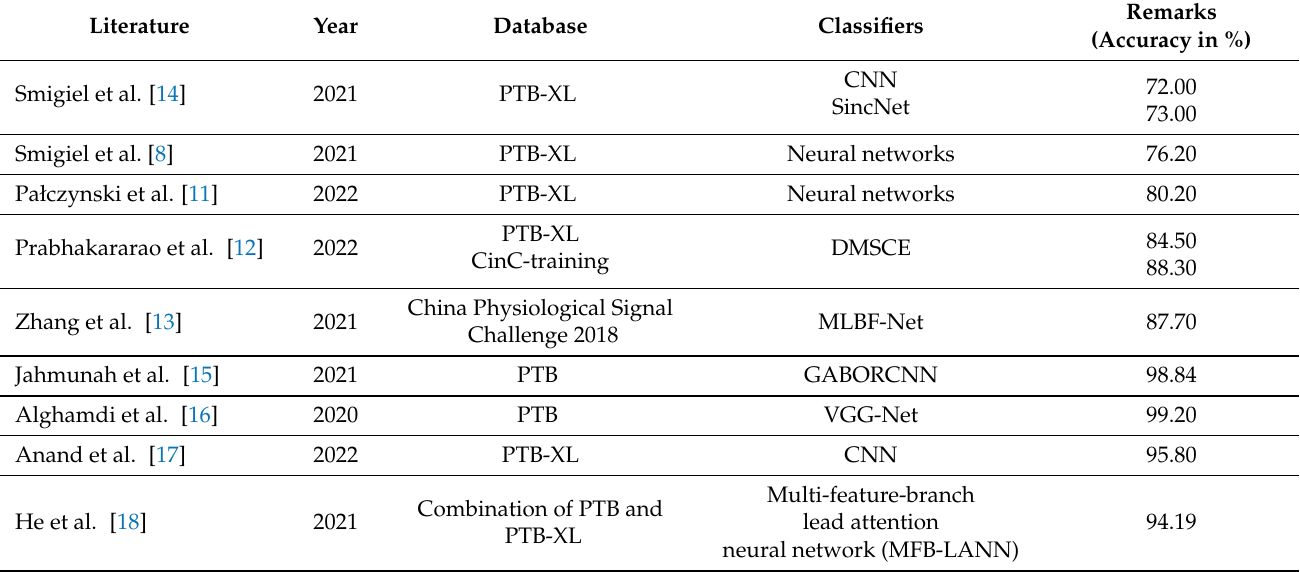
Table 1. Comparison of related